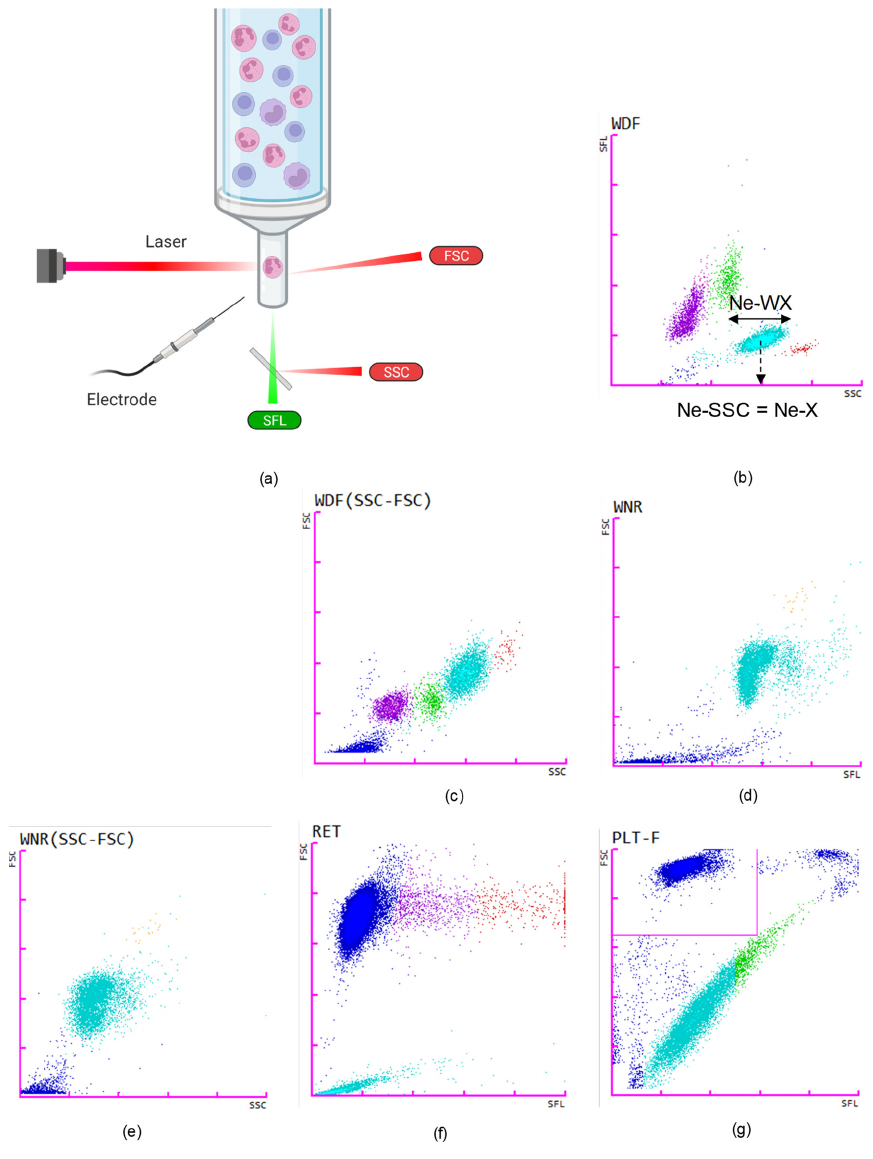
Figure 2. Illustration of the Sysmex technology. ( a ) The Sysmex-XN applies fluorescence-flow cy- tometry on cells to collect information on internal complexity (side scatter, SSC), nucleic acid content (fluorescence, SFL) and cell size (forward scatter, FSC. Created with BioRender.com. ( b ) Position of different cell populations on the white blood cell differential scatterplot (WDF). X-axis shows side scatter (SSC) of laser light, Y-axis represents side fluorescence (SFL). The different types of leuko- cytes are represented: light blue for neutrophils, pink for lymphocytes, green for monocytes, red for eosinophils and dark blue for platelets and debris. Neutrophil scattering parameters are illustrated by the dotted arrow for granularity (SSC) on the X-axis (Ne-X) and the horizontal arrow for neutro- phil side scatter area distribution width (Ne-WX). ( c ) White blood cell differential scatterplot (WDF).